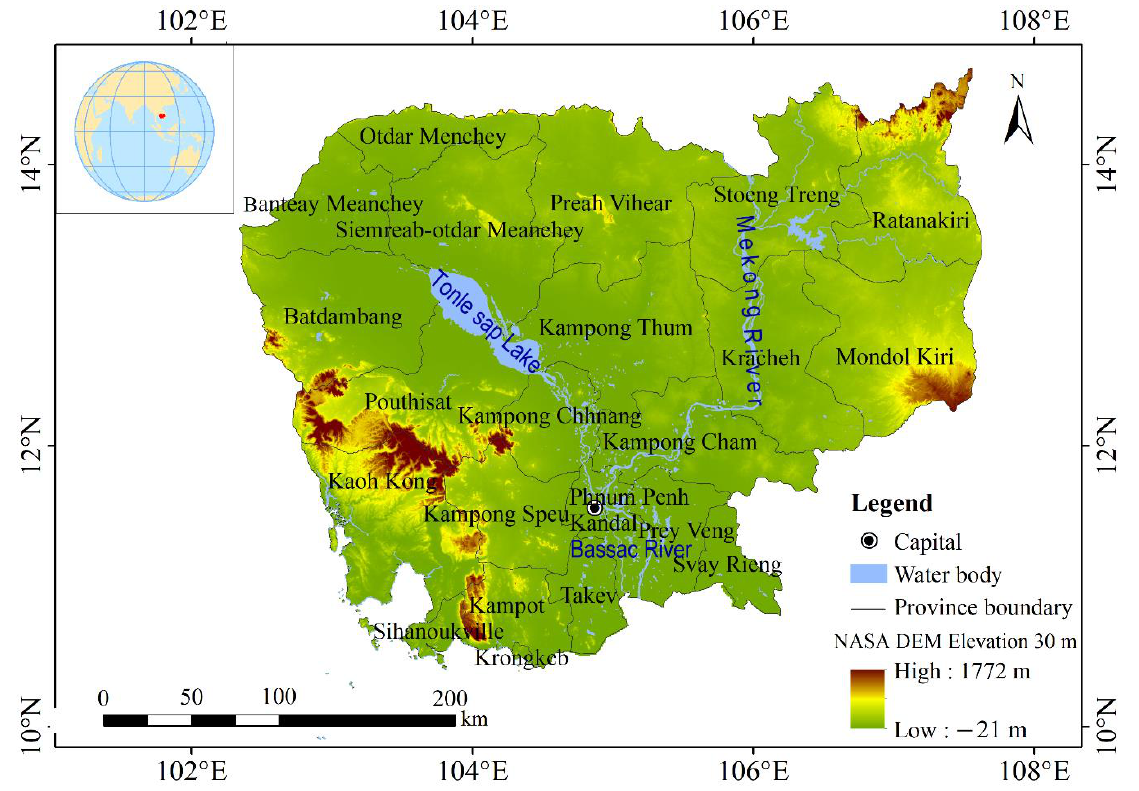
Figure 1. Location and topography map of Cambodia.